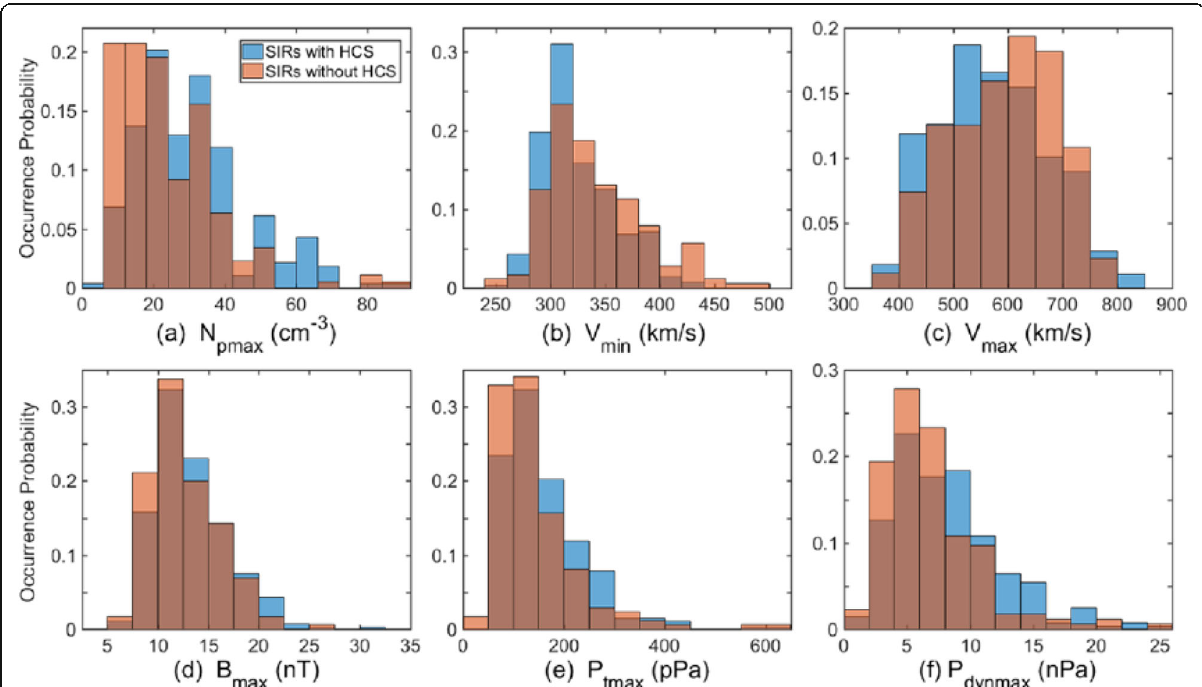
Fig. 33 The comparison of occurrence probabilities between SIRs with an HCS crossing (blue bars) and without any HCS crossing (orange bars) for the following parameters: a maximum N p , b minimum speed, c maximum speed, d maximum B, e peak P t , and f peak dynamic pressure. The brown shaded regions are the overlapping regions between SIRs with an HCS and the SIRs without any HCS crossing. Taken from Jian et al.